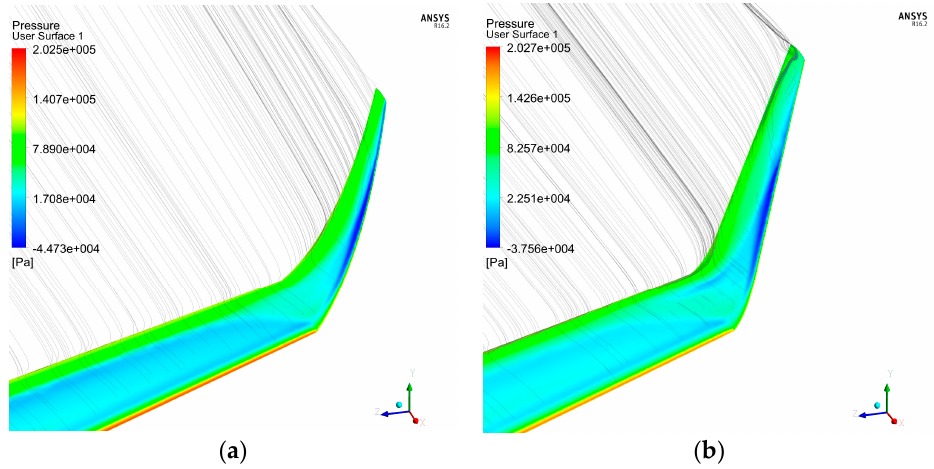
Figure 17. Surface pressure field and streamlines comparison at M = 0.8 and α = 2°: ( a ) Non-twisted Parabolic winglet ( b ) Non-twisted half canted ( ѱ = 45°) straight winglet.